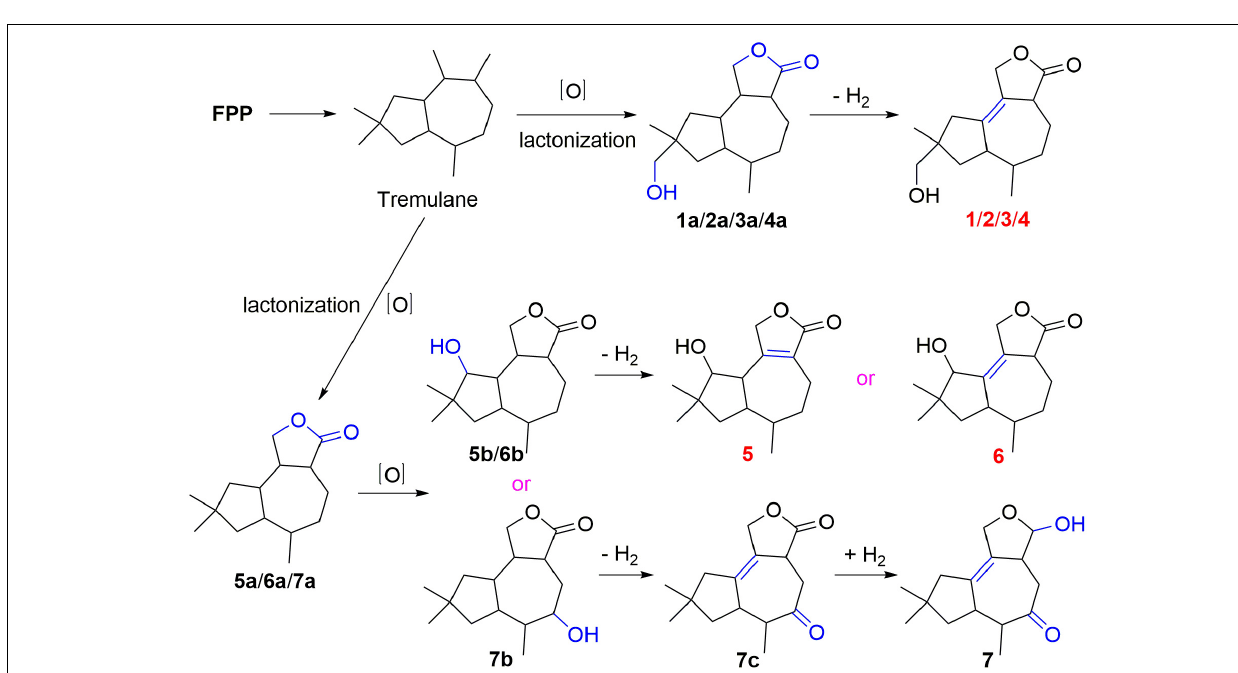
FIGURE 6 | Experimental and calculated ECD of compounds 1 – 6 .